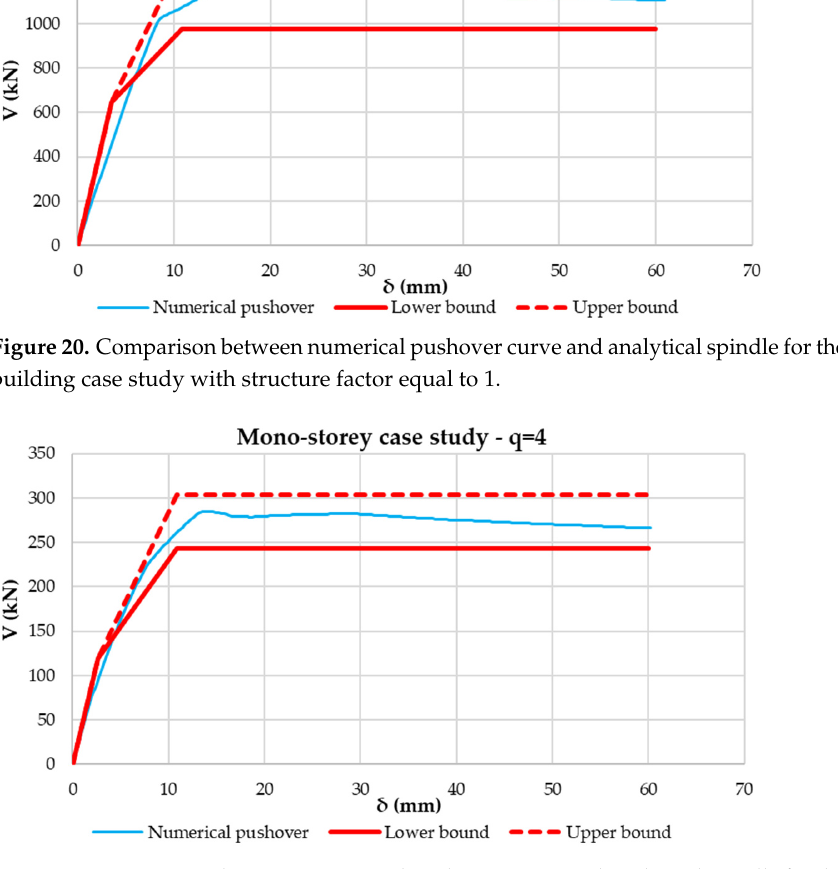
Figure 21. Comparison between numerical pushover curve and analytical spindle for the building case study with structure factor equal to mono-storey building case study with structure factor equal to 4.